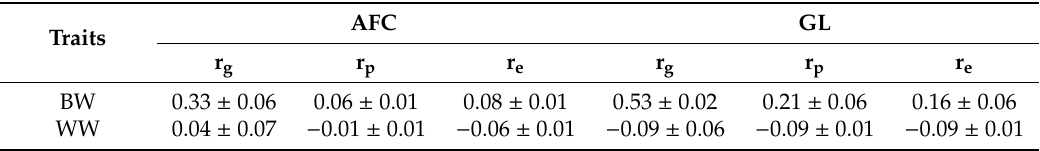
Table 3. Genetic, phenotypic, and residual correlations of birth weight (BW) and weaning weight (WW) to age at first calving (AFC) and gestation length